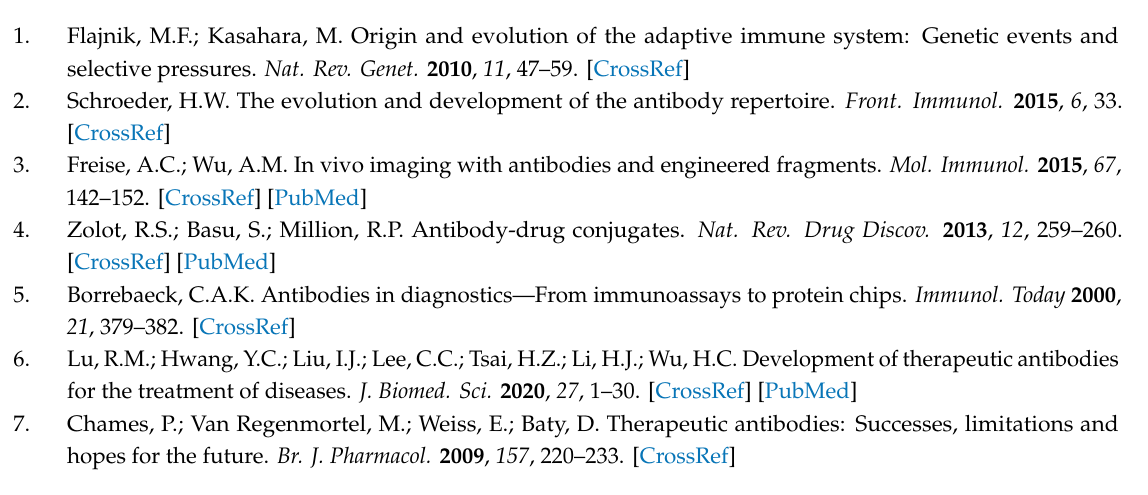
Figure S1: SPR equilibrium responses of Nb1 ( A ) and Nb6 ( B ) at a range of concentrations. KD values resulting from non-linear curve fitting to a 1:1 Langmuir model are reported in Table 1 (main text).; Figure S2: Semilogarithmic plots of the dissociation phases for Nb1 ( A ) and Nb6 ( B ) at 50 nM over a range of temperatures, indicating that dissociation largely follows first-order kinetics at each temperature (note the exception for Nb6 at 37 ◦ C, with a very fast dissociation that deviates from